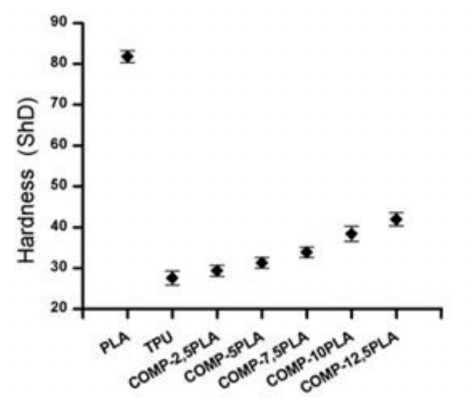
Figure 5. Hardness of obtained compositions.